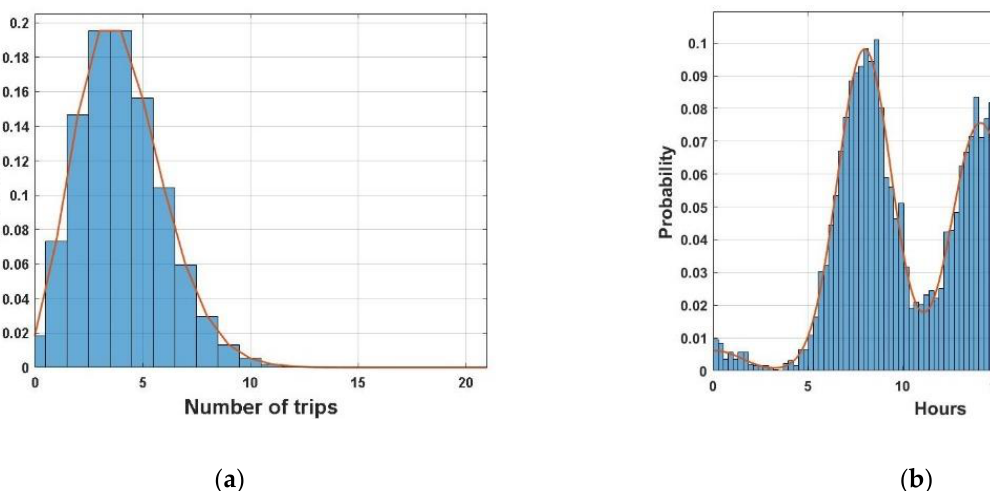
Figure 6. ( a ) Probability distribution for the number of journeys per day ( λ = 4); ( b ) Probability of departure time during 24 hrs.